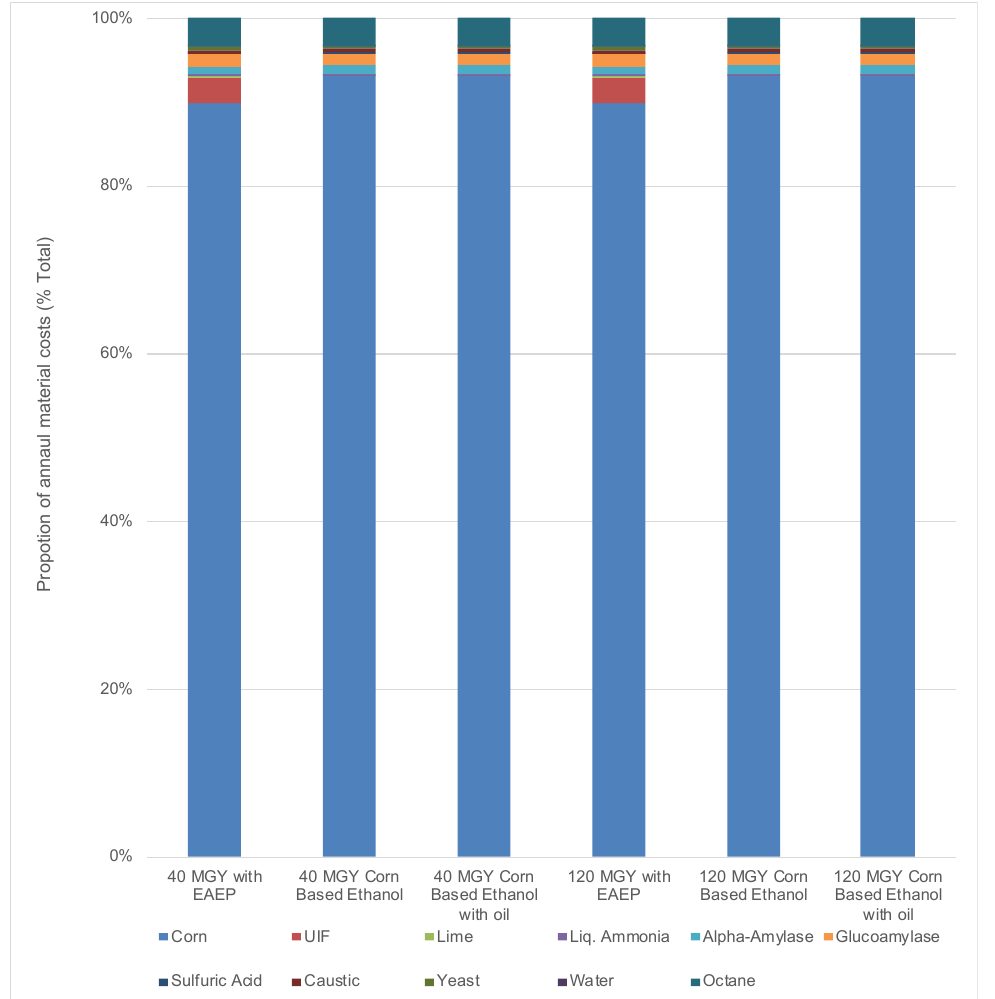
Figure 4. Material costs for integrated corn-soy ethanol fermentation processing. Scenarios include a 40 million gallon per year (MGY) ethanol plant with or without corn oil separation, a 120 MGY ethanol with or without corn oil separation, and a 40 or 120 MGY ethanol plant, without corn oil separation but with EAEP products used for fermentation.